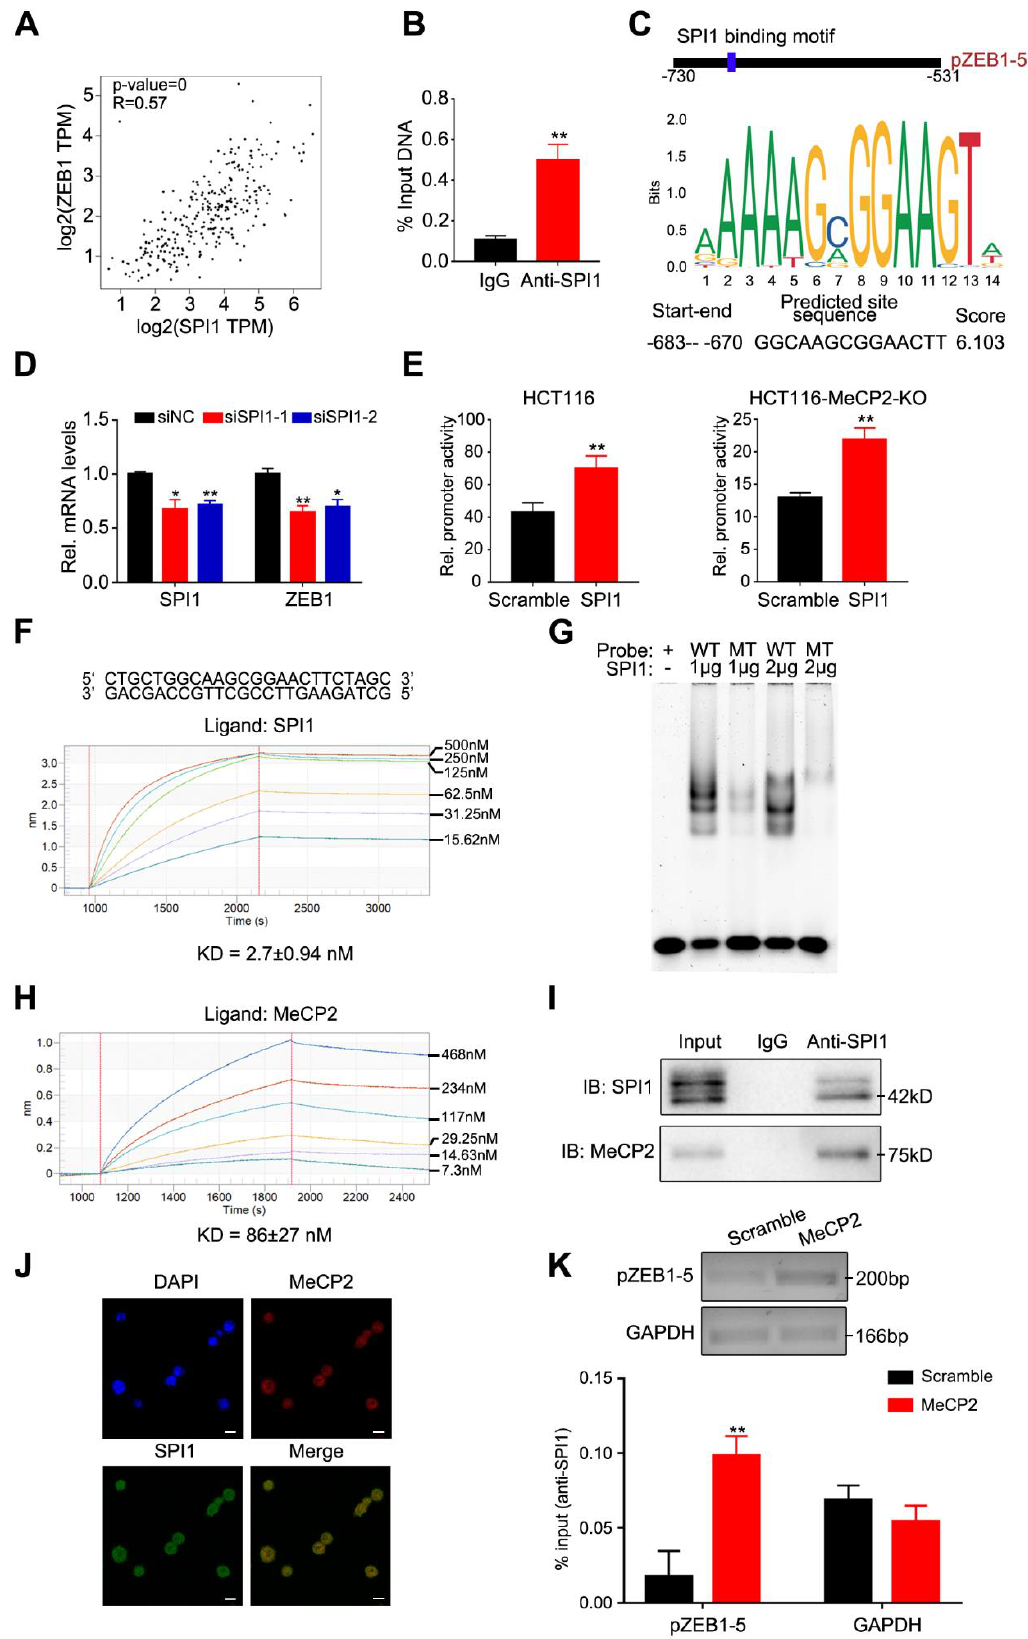
Figure 6. ZEB1 is a transcriptional target of the MeCP2-SPI1 complex. ( A ) Correlation between ZEB1 and SPI1 expression in the Cancer Genome Atlas (TCGA) database for colon adenocarcinoma (COAD), analyzed with the Gene Expression Profiling Interactive Analysis (GEPIA) online analysis